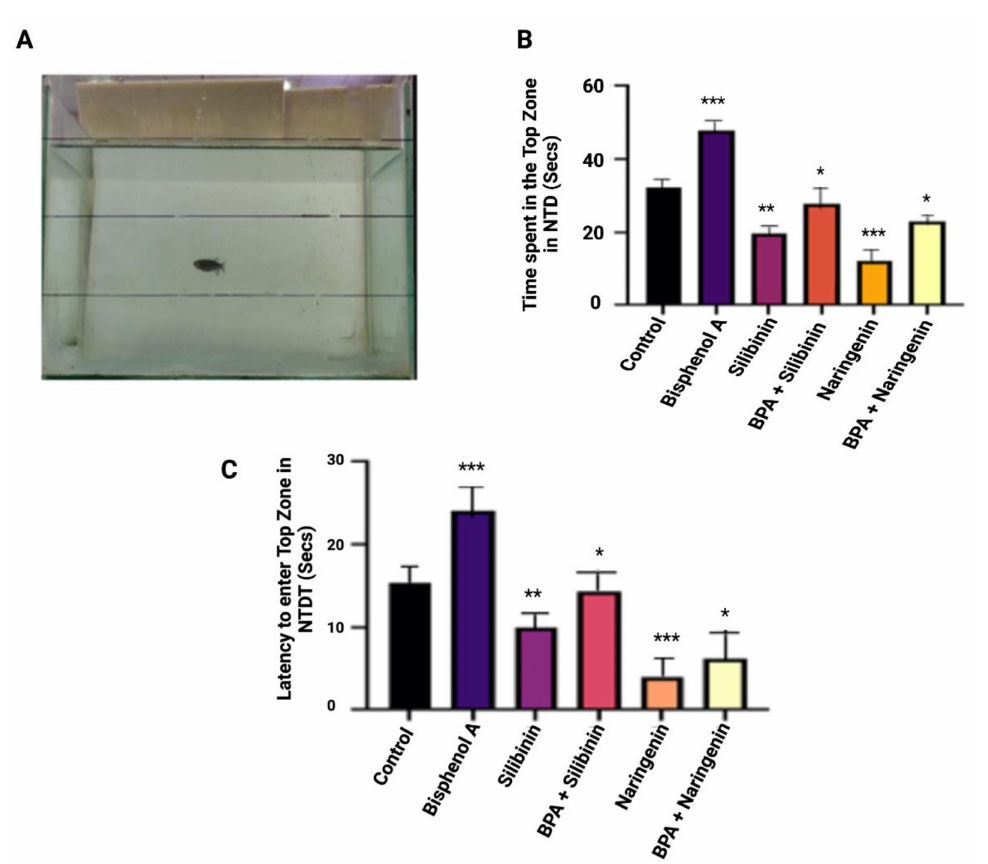
Figure 4. ( A ) Novel tank set up and ( B ) time spent in the top zone in the NTD ( C ) Latency to enter the top zone in NTDT. The values are expressed as means ± SEM, n = 10 fish in each groups. The significance was analysed using a one-way ANOVA. Note: * p < 0.05, ** p < 0.01, *** p < 0.001 compared with the control